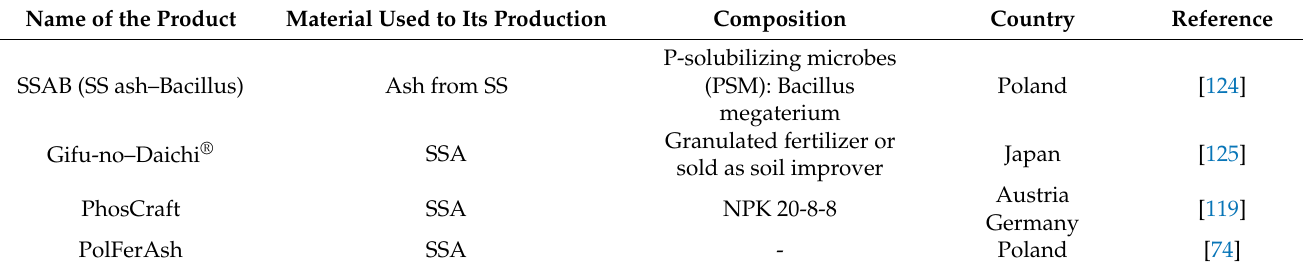
Table 4. Fertilizers produced on the base of SSA as a product ending the closed phosphorus cycle. Name of the